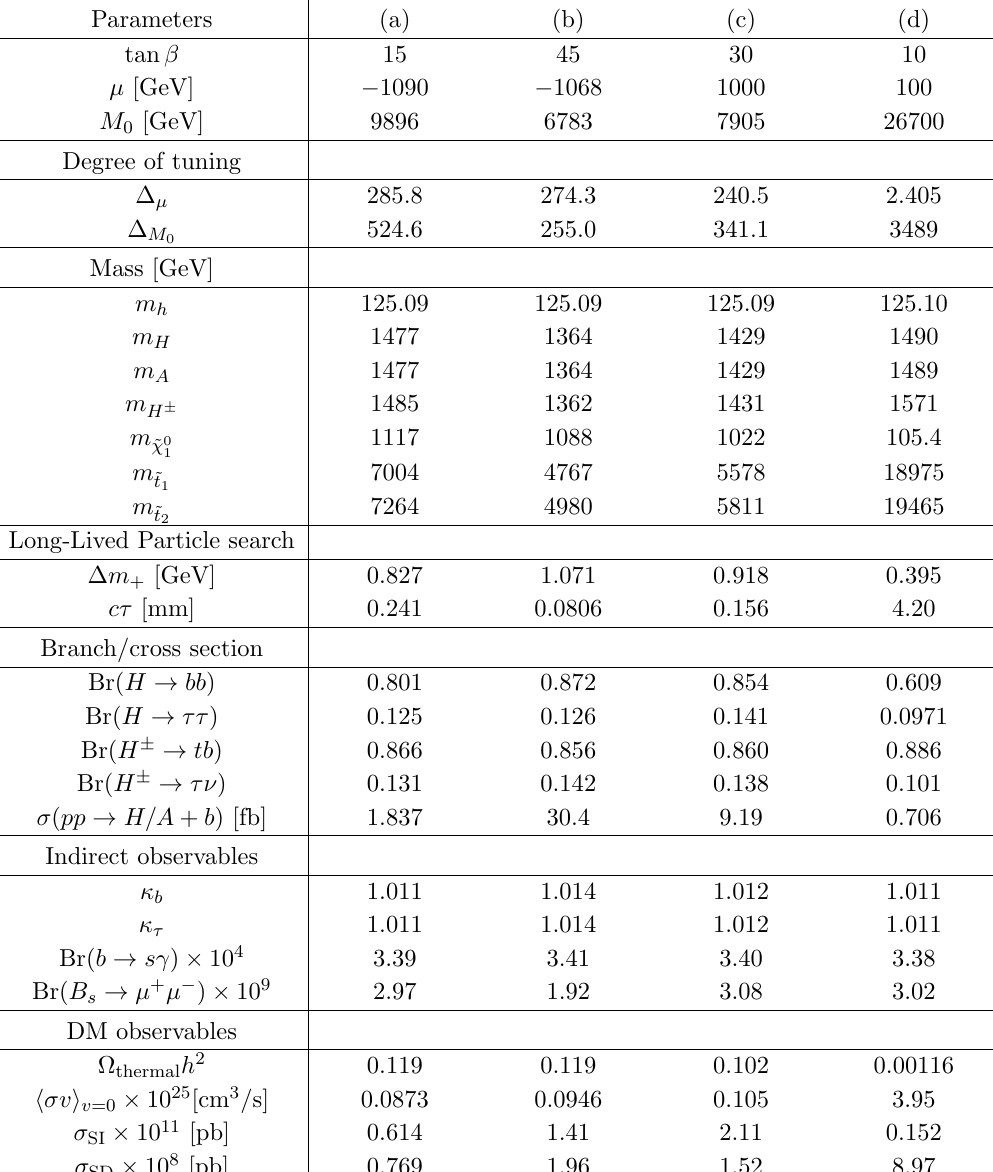
Table 1 . Values of parameters, masses, widths, branching ratios, production cross section of H=A in association with a b-quark, (cid:20) b;(cid:28) , (cid:13)avor observables and DM observables at benchmark points